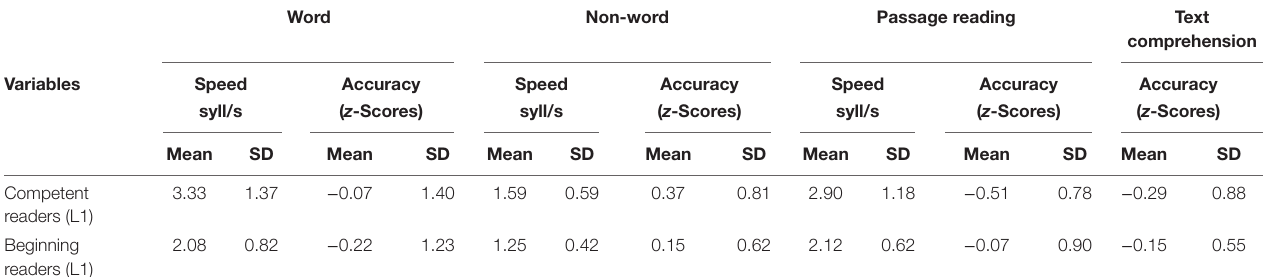
TaBle 2 | Reading and spelling performances of L1 competent and beginning readers on the standardized reading tests.